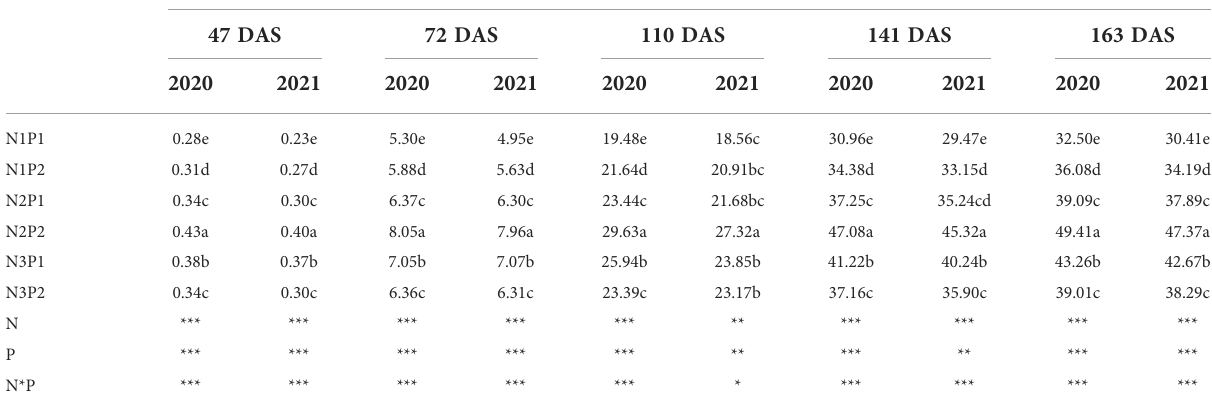
TABLE 2 Effects of different nitrogen and phosphorus combinations on fresh biomass yield of sesbania pea at different growth stages in saline soils in 2020 and 2021. Treatment